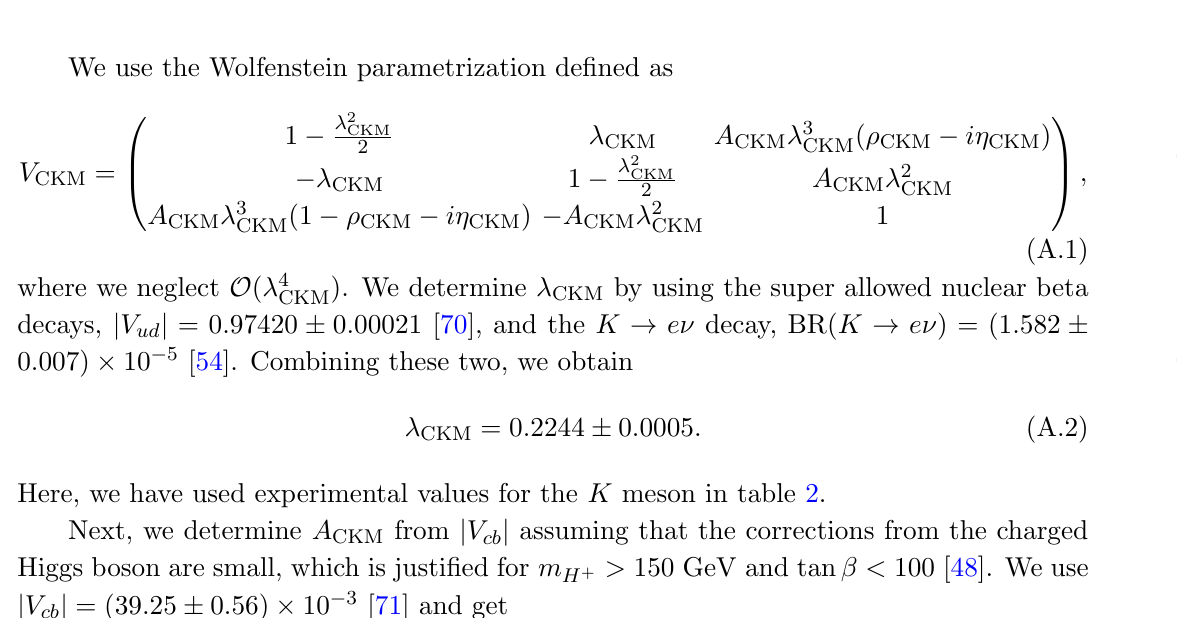
Table 2 . Experimental and theoretical parameters for mesons. The uncertainties are used for the evaluation of theoretical uncertainties in the (cid:13)avor